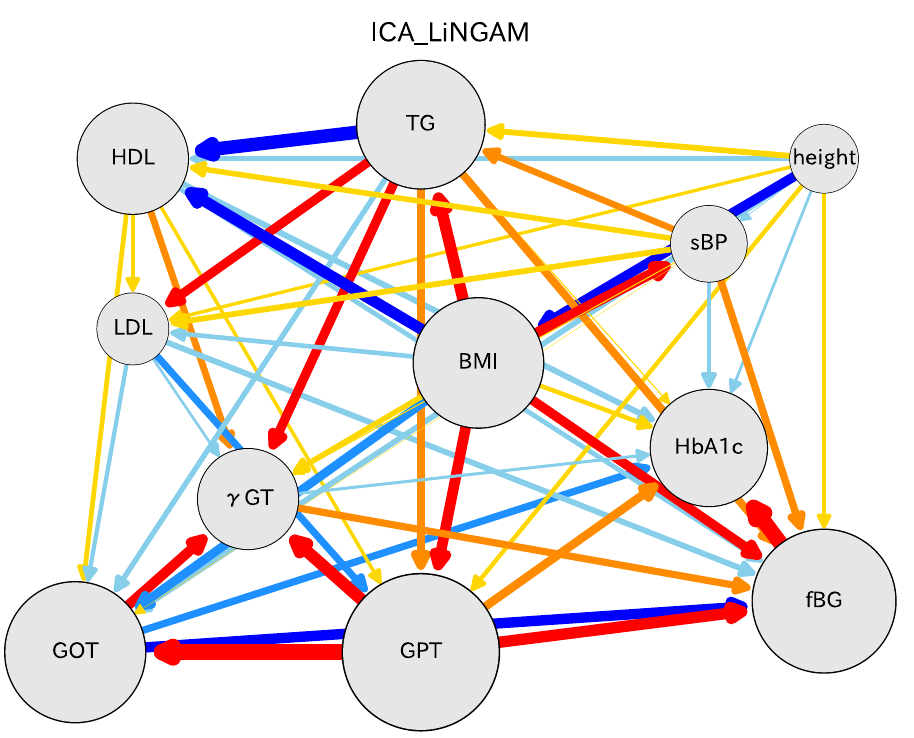
Fig 8. Causal diagram for women in their 70s. We use the ICA-LiNGAM algorithm for this causal relation. For this figure, we take 11 indices as DirectLiNGAM in Fig 3. The arrow colors and the thicknesses are used for the causal relations, as depicted in Fig